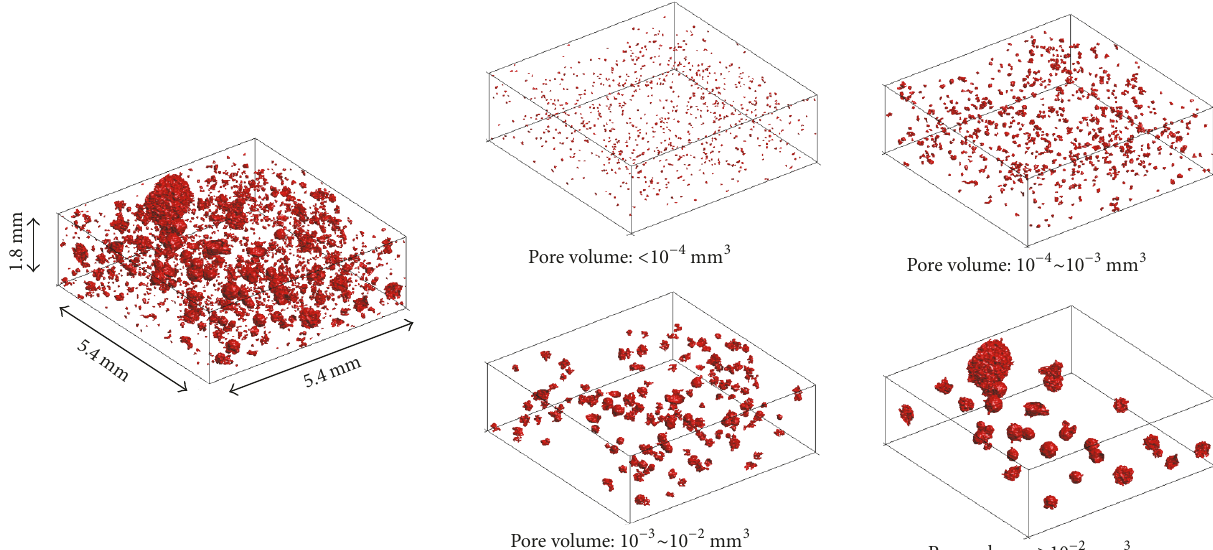
Figure 5: Reconstructed 3D micropore structure of the FA sample (separated micropores based on pore-volume